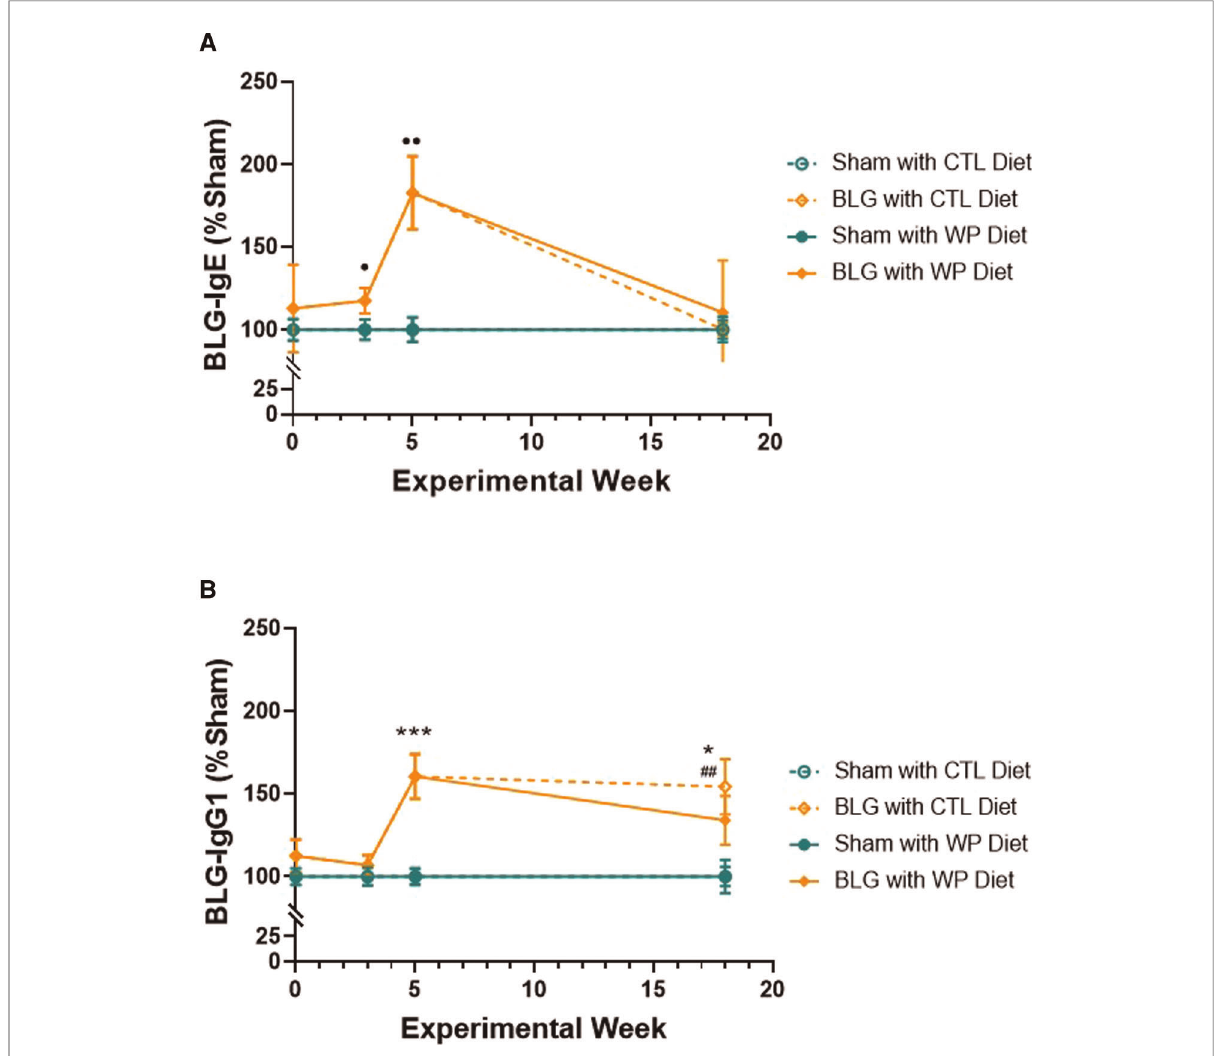
FIGURE 2 Relative quanti fi cation of BLG-speci fi c immunoglobulin levels. Plasma samples were isolated from sham and BLG-sensitized mice on Weeks 0, 3, 5 and 18, and BLG-speci fi c IgE ( A ) and IgG1 ( B ) were quanti fi ed using ELISA. The optical density (OD) value from each colorimetric reaction was normalized to the average OD value of the respective sham group and expressed as % sham. All mice were fed the CTL diet during the sensitization period, and thus, the mice receiving the same sensitization were grouped for Week 0 ( n =15 – 19), Week 3 ( n =23), and Week 5 ( n = 24). For Week 18, the values from the four experimental groups are individually indicated ( n =12 per group). Sham vs . BLG groups at Week 0, 3, and 5 were compared using Mann – Whitney ’ s U -test; the four experimental groups at Week 18 were compared using two-way ANOVA. Values shown are the group average±SEM. p <0.05, p <0.01 (Mann – Whitney ’ s U -test); *** p <0.001, * p <0.05 (two-way ANOVA with Tukey post hoc test); p <0.01 (two-way ANOVA with Fisher ’ s LSD). See Supplementary Figure S1 for detailed values at the individual time